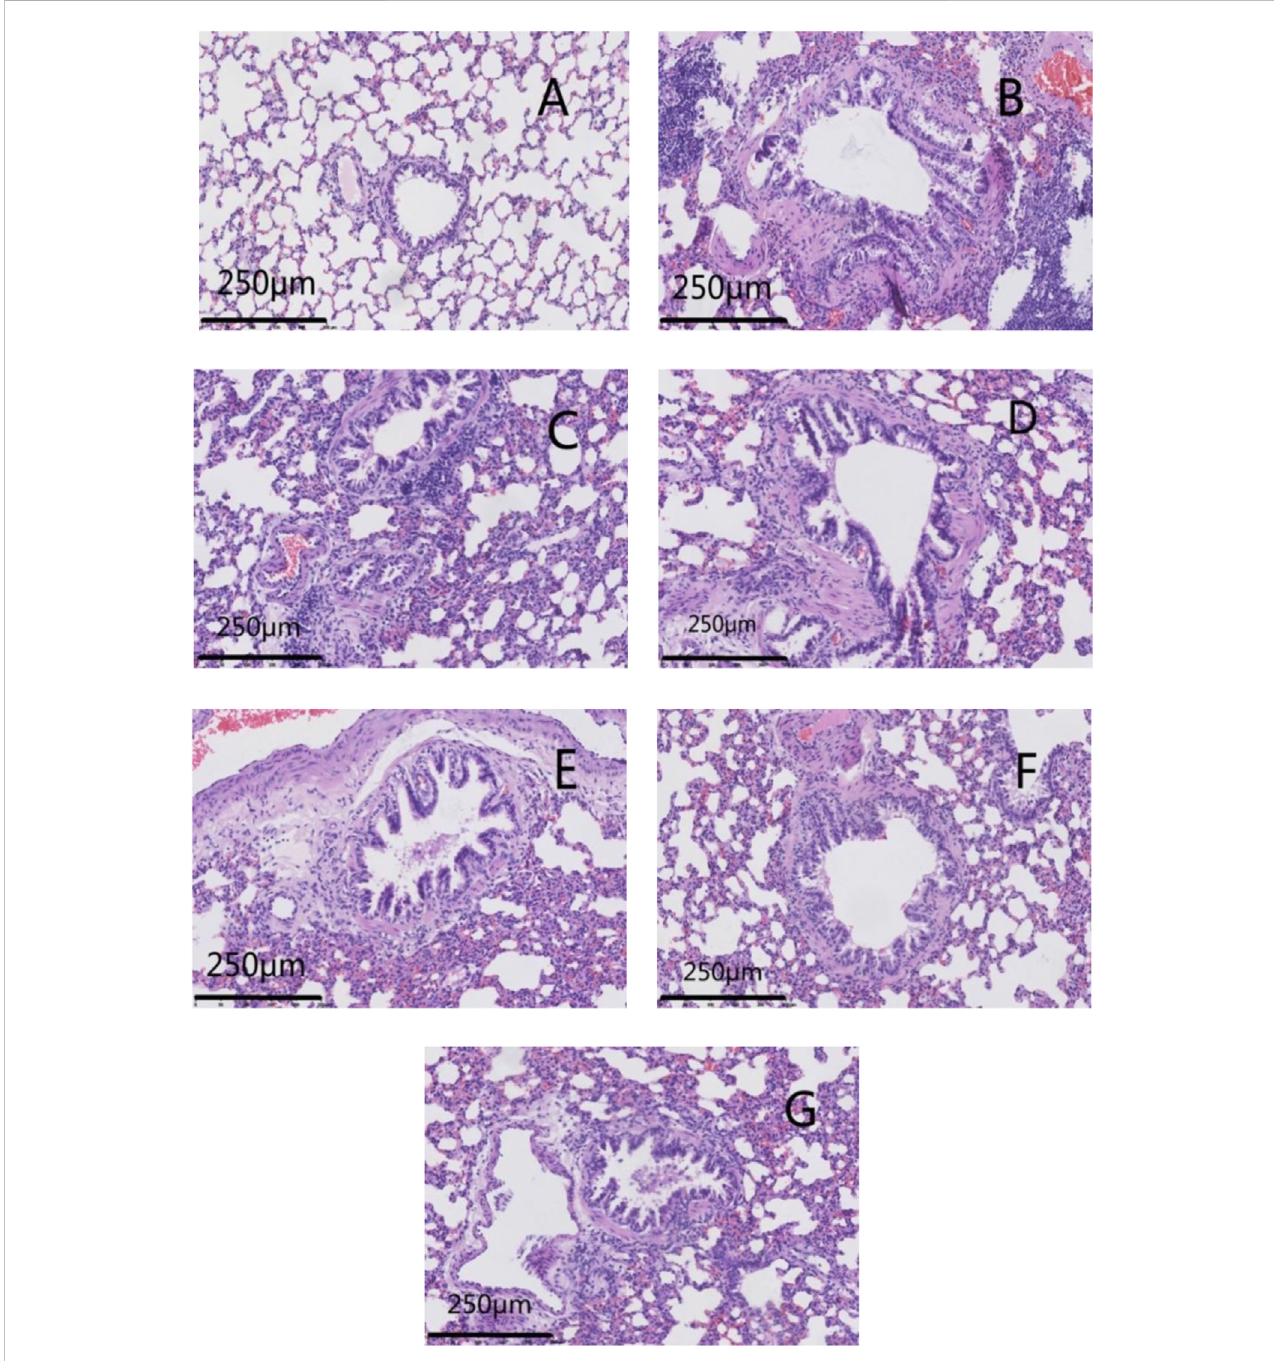
FIGURE 6 Effects of GSZC granules on the histopathology of lungs in rats suffering from asthma. Micrographs represent H&E staining in lung tissues. (A) is the normal group, (B) isthemodelgroup, (C) istheGSZClow dosage group, (D) istheGSZCmoderatedosage group, (E) istheGSZChigh dosage group, (F) isthe Dexamethasone acetate group, (G) is the Yupingfeng granules + Liujunzi pills group, respectively. Scale bar: 250 μ m. Magni fi cation: